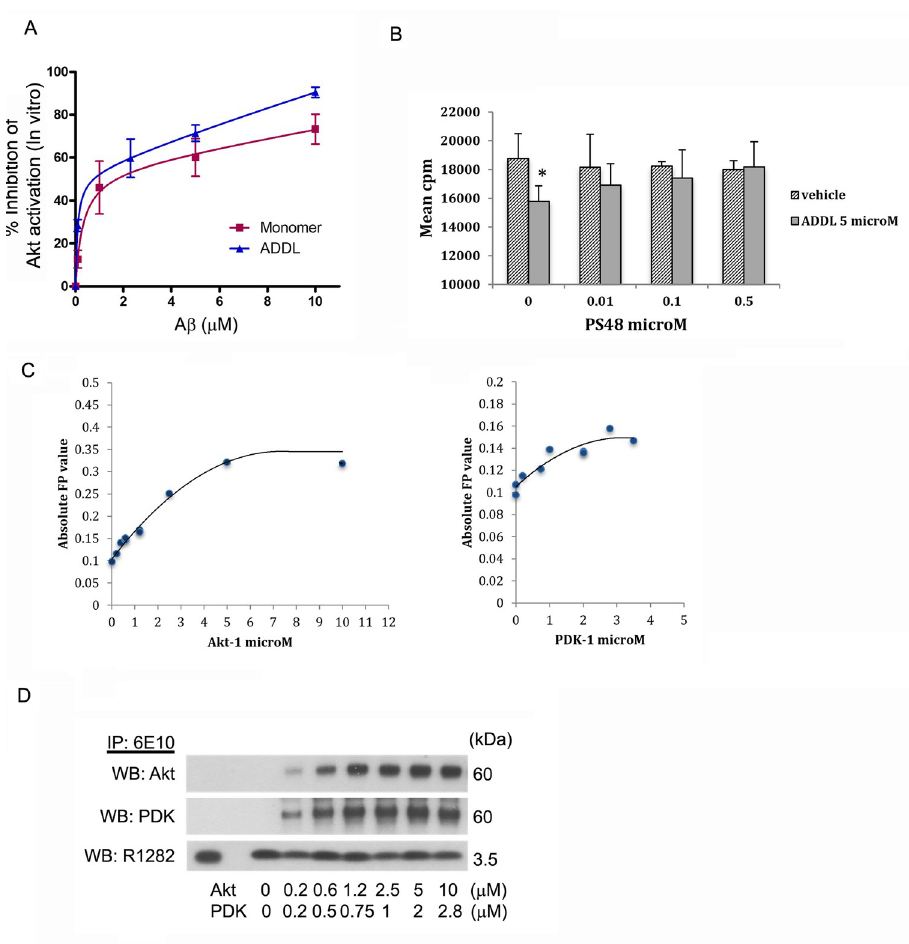
Fig 5. Equilibrium enzymatic and binding studies. PDK-1 and Akt-1 are A β 42 targets. 5A . A β 42 monomers and ADDL-oligomer preparations, at concentrations shown, exhibit saturation effects to inhibit the activation of Akt by PDK-1. In vitro assay data are presented as % inhibition of either activation of Akt (phospho-T308) by PDK-1 or of its subsequent activity to phosphorylate a GSK3 β consensus peptide fused to paramyosin (’crosstide’). Densitometry results from both western blots were combined. Imax ~ 52% for both A β preparations: ADDL, K0.5 = 0.08 μ M; monomers, K0.5 = 0.31 μ M. n = 2–7 experiments each point, ± 1 SEM. 5B. In vitro radioassay (see methods). PS48 from 10 nM to 0.5 μ M, gradually diminishes the inhibitory effect of A β (5 μ M ADDL alone, bar 2, � p < .05 vs. vehicle) on the phosphorylation of GSK peptide (measured in cpm). The trend is toward control activity, not significant from bar 1 or other vehicle controls. 5C . Quantification of A β 42 binding to kinase targets by fluorescence polarization (FP). The probe was FAM-tagged-A β 42. Recombinant kinase titrations shown along bottom. The spectrophotometric polarization signal increases as the probe becomes more restricted by receptor binding. Bmax: Akt 0.32; PDK 0.16. IC50: Akt ~2 μ M, PDK ~1 μ M. 5D . Direct binding of recombinant PDK-1 and Akt-1 to tagged A β 42 in solution is confirmed and exhibits saturation characteristics. A β 42 was immunoprecipitated (6E10), fractionated by Western and co-precipitates are detected using anti- Akt and -PDK. A β 42 concentration was fixed at 200 nM and detected using polyclonal R1282. Lane 1 is A β peptide control, lane 2 is beads without 6E10 control. using the fluorescence polarization (FP) technique. A spectrophotometric filter detects the fluorescent signal from a probe that becomes polarized once restricted by receptor binding. We found that the FP signal increases as the concentration of either recombinant PDK or Akt are increased. The probe concentration (FAM tagged-A β = 200 nM) is fixed in this procedure. Results shown are from 2 experiments each. Saturable binding to A β is shown by both target molecules, where the Kd (1/2 max constant) for PDK shows slightly increased affinity over